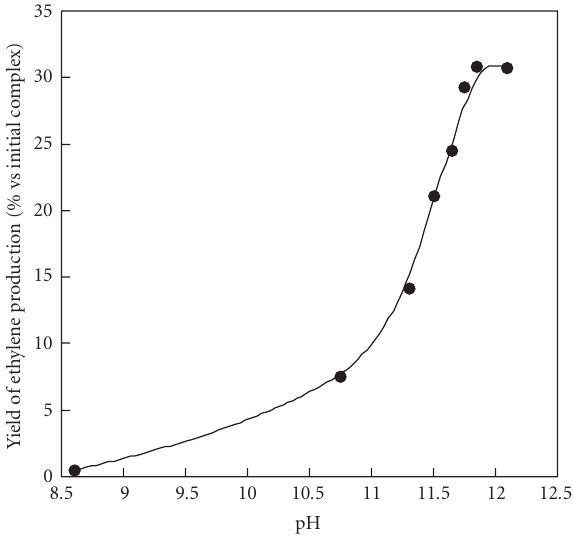
Figure 6: Ethylene produced by complex 1 in water as a function of pH. The pH was adjusted by addition of NaOH.